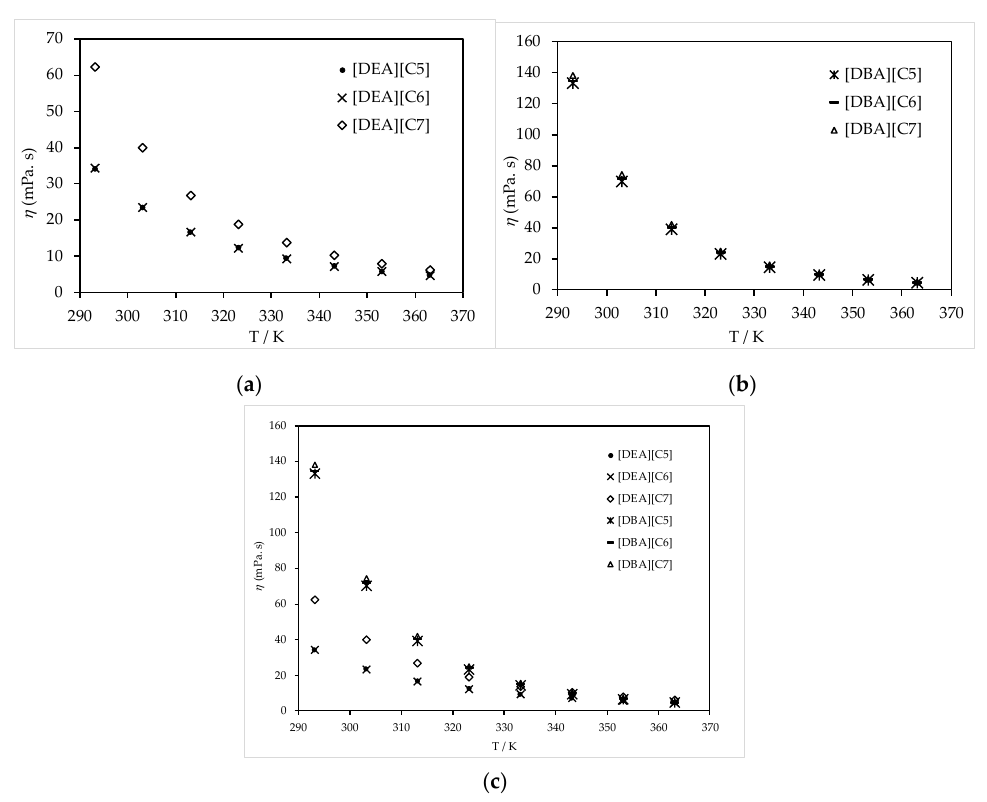
Figure 2. ( a ) Viscosity ( ƞ ) of [DEA][C5], [DEA][C6] and [DEA][C7] as a function of temperature. ( b ) Viscosity ( ƞ ) of [DBA][C5], [DBA][C6] and [DBA][C7] as a function of temperature. ( c ) Viscosity ( ƞ ) of all six ammonium-based PILs as a function of temperature.